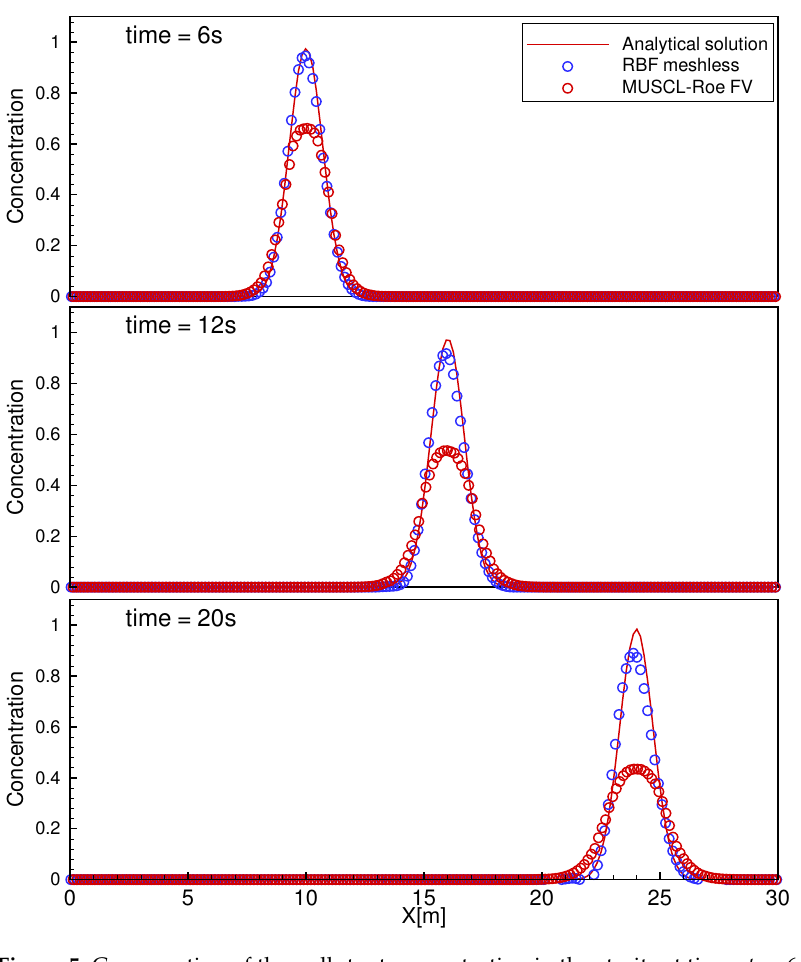
Figure 5. Cross-section of the pollutant concentration in the straits at times t = 6 s, 12 s, and 20 s at y = 5 m.